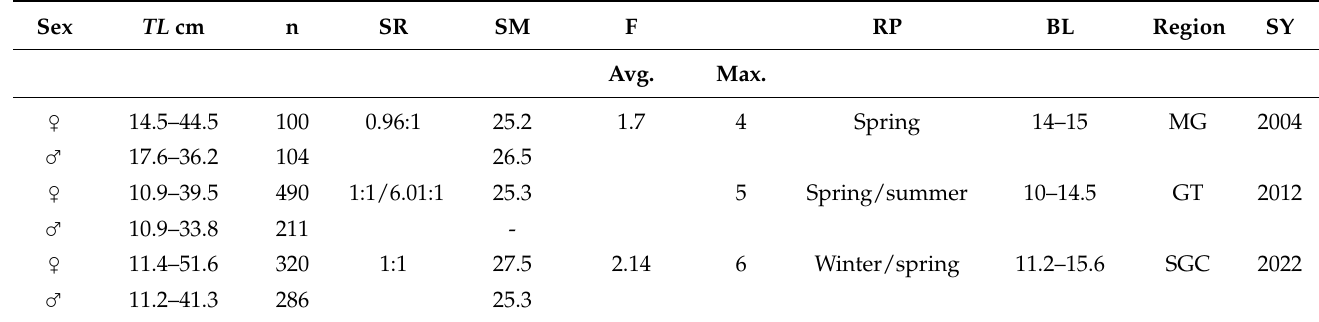
Table 4. Comparison of the reproductive parameters of U. chilensis in different areas of the Mexican Pacific, including the present study (SGC). Ref. [30] (Michoacan and Guerrero, central Mexican Pacific, MG) and [31] (Gulf of Tehuantepec, southern Mexican Pacific, GT). Ref. [32] does not report TL 50 for the males nor average fecundity. SR = Sex Ratio; SM = Size at Maturity (cm); F = Fecundity; RP = Reproductive Period; BL = Birth Length (cm); SY = Study